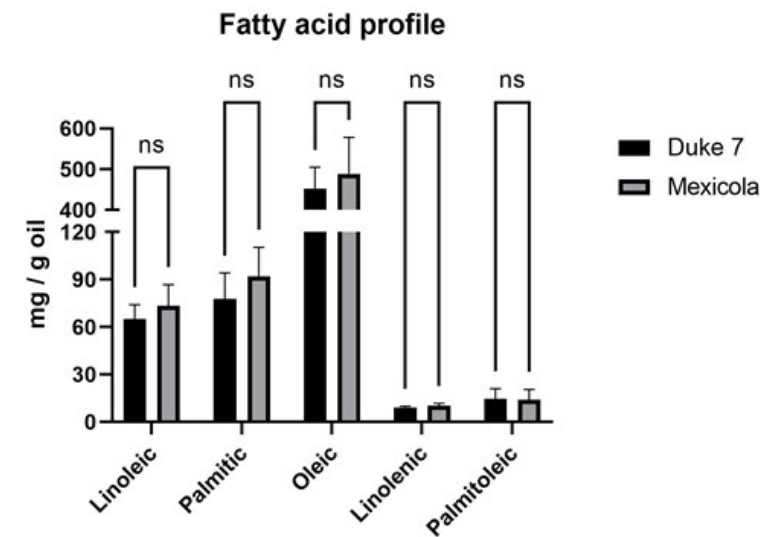
Figure 4. Fatty acid profile of Hass avocado fruit from “Mexicola” and “Duke 7” rootstocks corre- sponding to early harvest of the 2016/2017 season. A one-way ANOVA was performed. Significant differences were assessed at a p -value < 0.01 (ns, not significant).